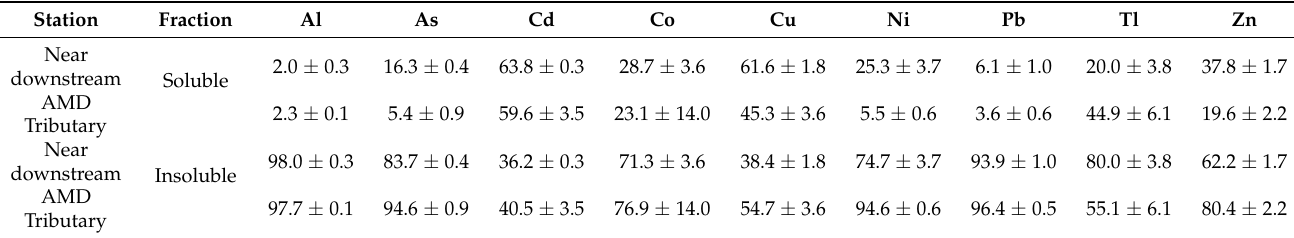
Table 5. Contribution (%) of the soluble and the insoluble fractions in bioaccumulation of metals in C. riparius larvae. Data are mean ± standard deviation ( n = 3). Different letters indicate significant differences between